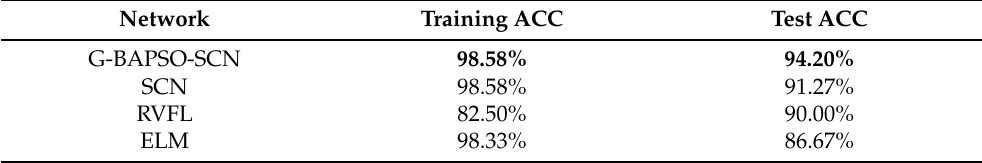
Table 11. Performance comparison results (Dataset